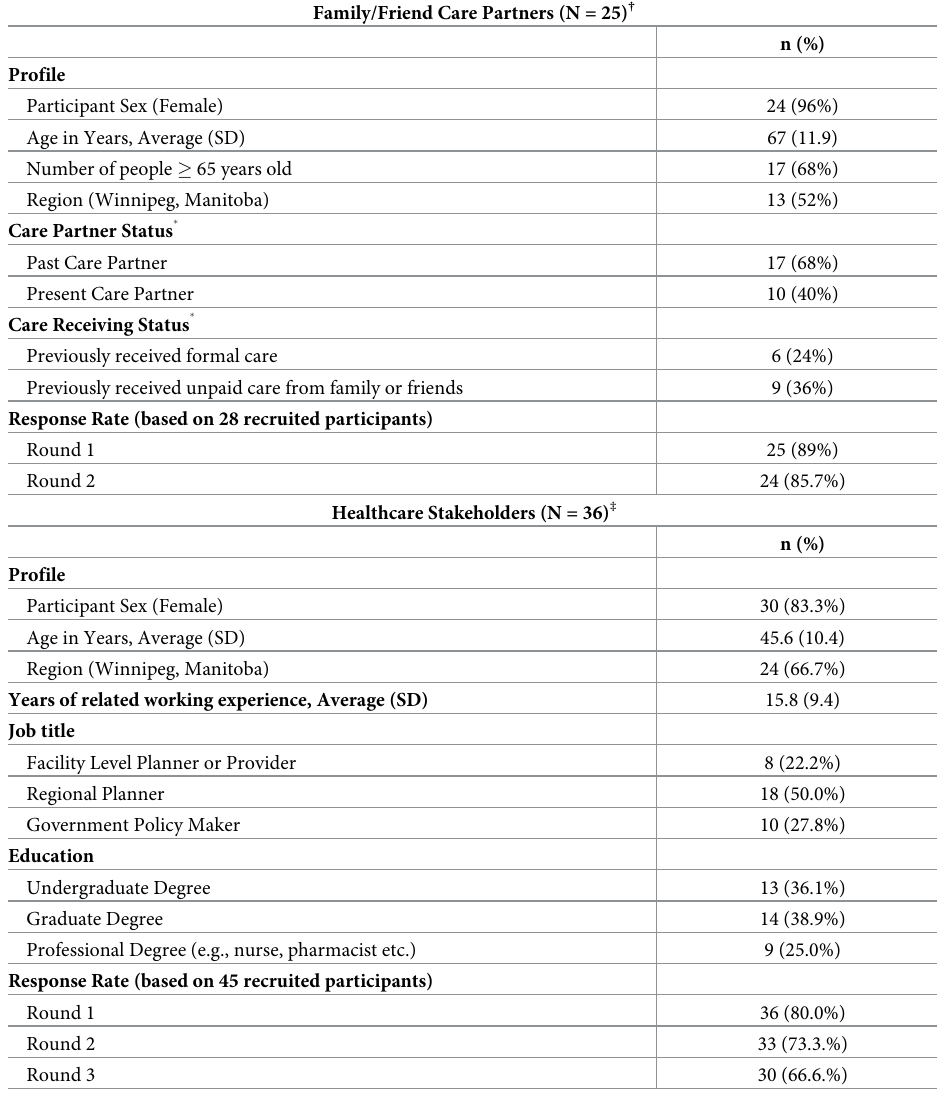
Table 2. Description of Delphi participant characteristics. Family/Friend Care Partners (N = 25)